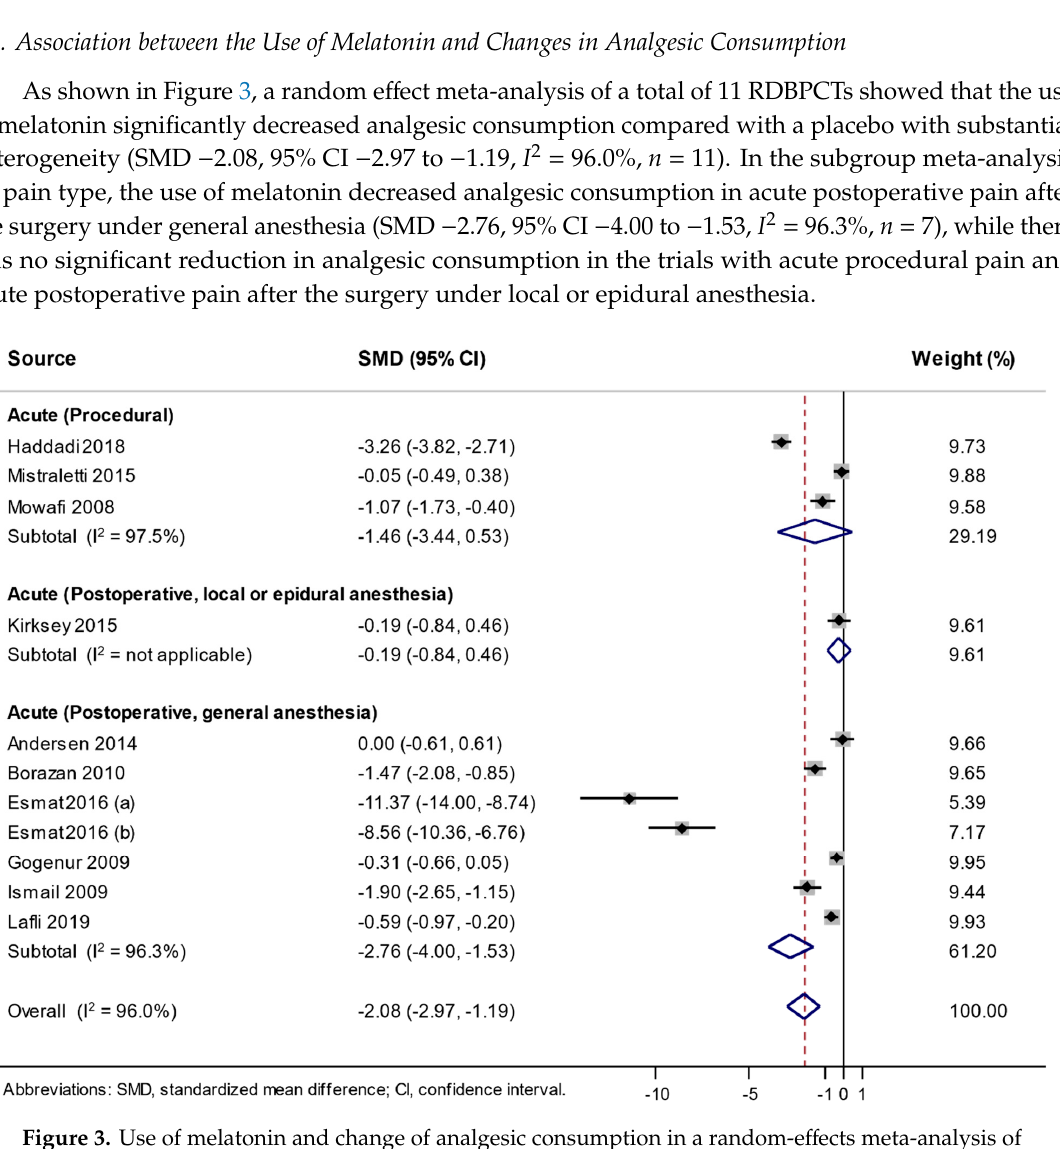
Figure 3. Use of melatonin and change of analgesic consumption in a random-effects meta-analysis of randomized, double-blind, placebo-controlled trials.